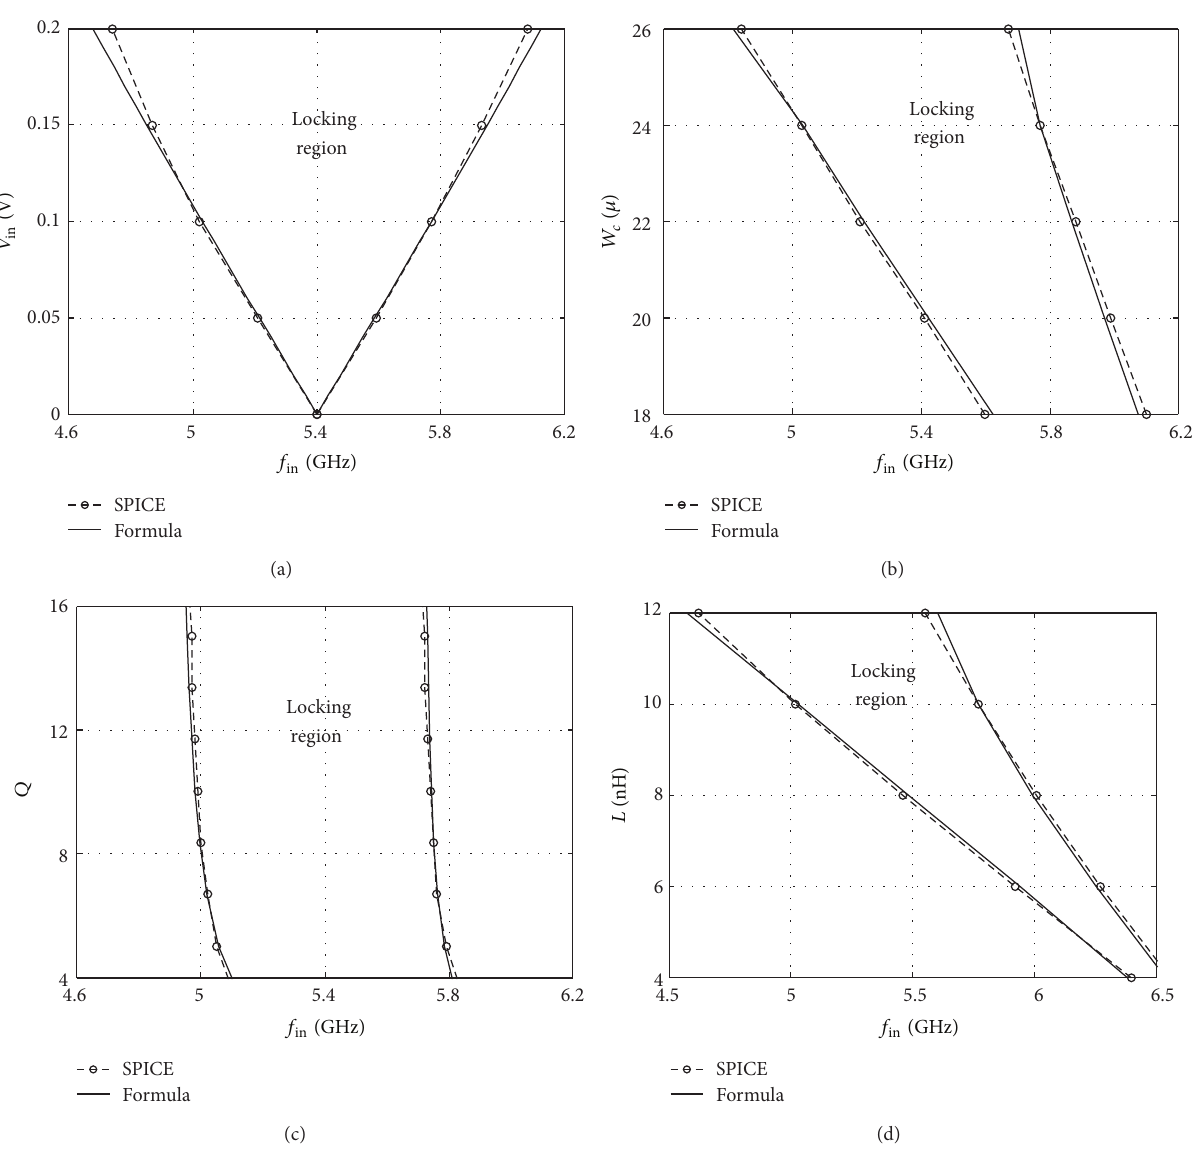
Figure10:Lockingregionsforthedivide-by-threeILFDinFigure 5,obtainedbySPICEsimulations(lineswithcircles)andbyusinganalytical equations (lines without circles). For SPICE simulations, BSIM3 transistor models in MOSIS-IBM 8RF 0.13 𝜇 technology with 𝑉 have been used. (a) Locking range as a function of the input amplitude ( 𝐿 = 10 nH, 𝑅 = 905 Ω ). (b) Locking range as a function of the transistor sizes ( 𝑊/𝐿 𝑐 = 𝑊/𝐿 𝑖 , 𝐿 = 10 nH, 𝑅 = 905 Ω ). (c) Locking range as a function of the tank resistance ( 𝑊/𝐿 𝑐 = 𝑊/𝐿 𝑖 = 24/0.12 , = 4.5𝑊/𝐿 𝑊/𝐿 ). (c) Locking range as a function of the 𝐿/𝐶 ratio keeping the 𝐿𝐶 product constant ( 𝐿𝐶 = 10 nH 446.6 PMOS NMOS